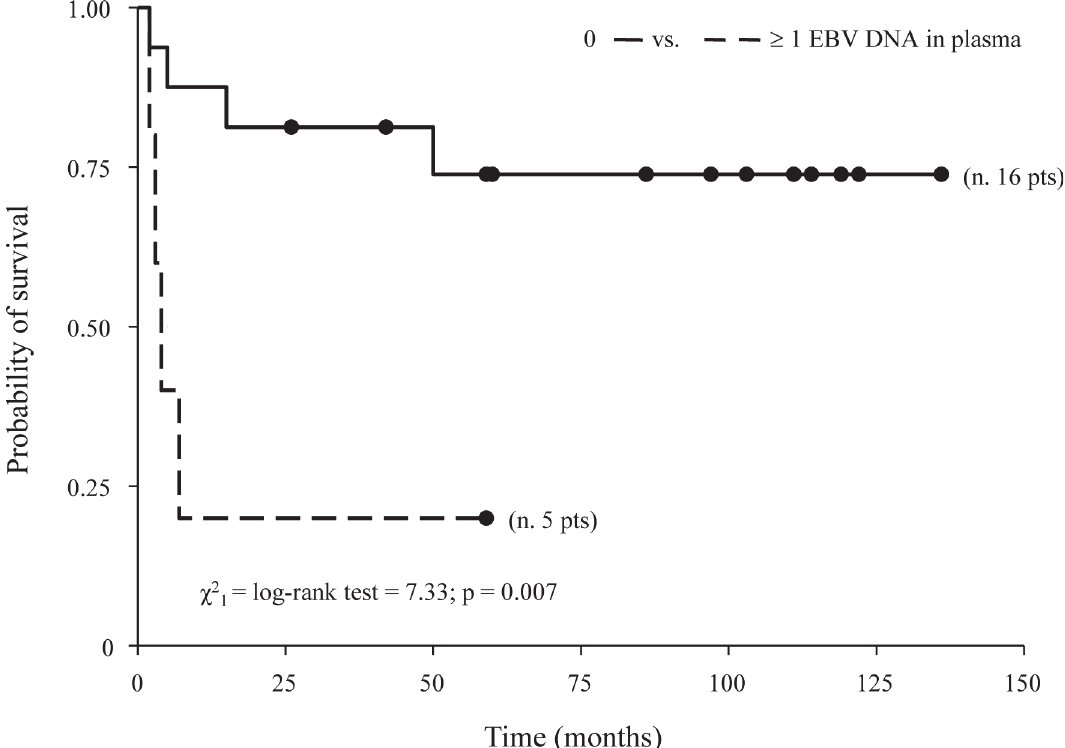
Figure 1. Kaplan-Meier estimates of overall survival by plasma EBV-DNA post-DCT in HIV-1-associated lymphoma patients. DCT, debulking chemotherapy.